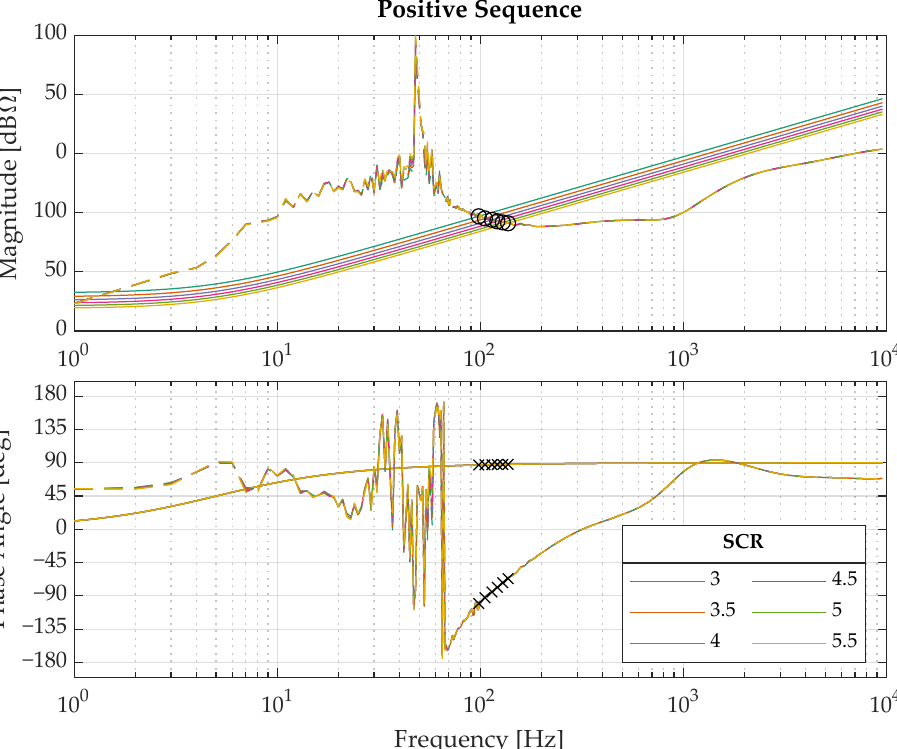
Figure 22. Bode plots of MMC in grid-following control mode and AC grid for different SCRs with positive-sequence perturbation.